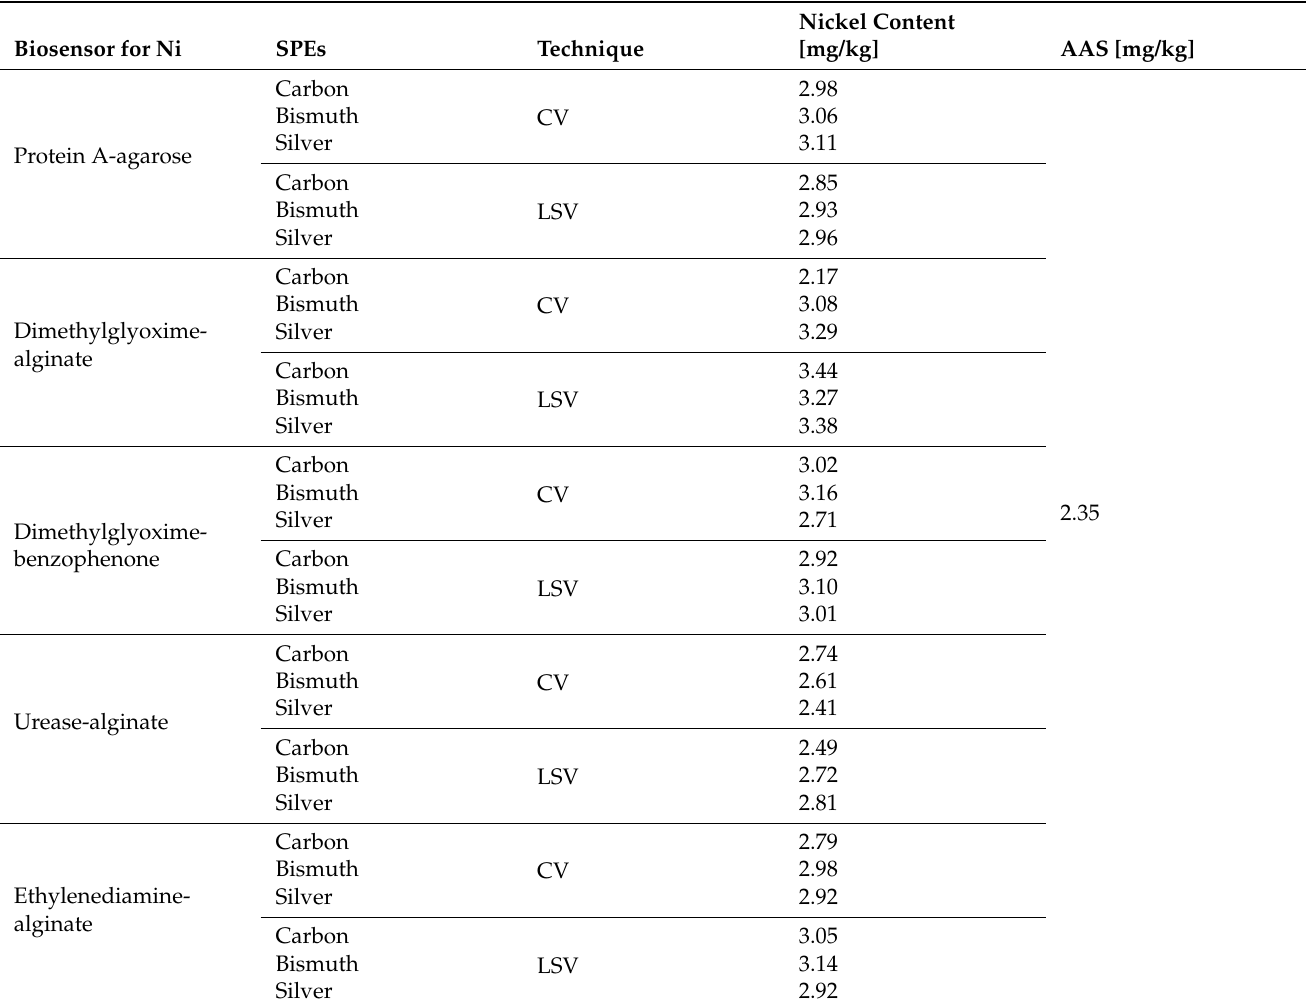
Table 5. Nickel content in white potato ( Solanum tuberosum